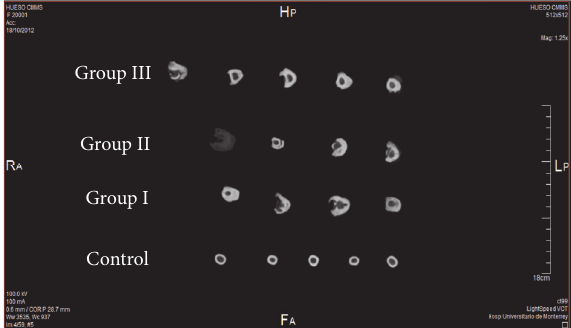
Figure 7: 3D computerized tomography of a sagittal slice of sheep bones 10 weeks after surgery (postmortem) represented by